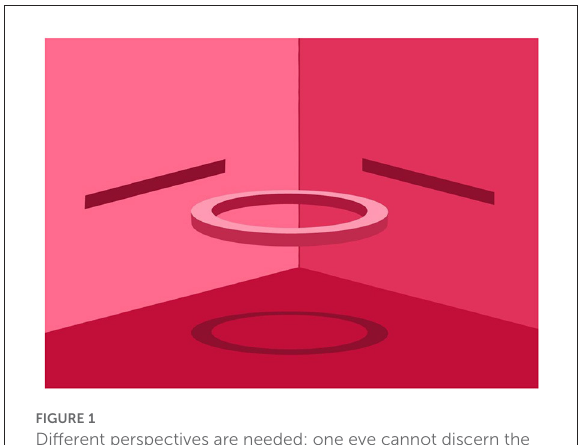
FIGURE1 Different perspectives are needed: one eye cannot discern the